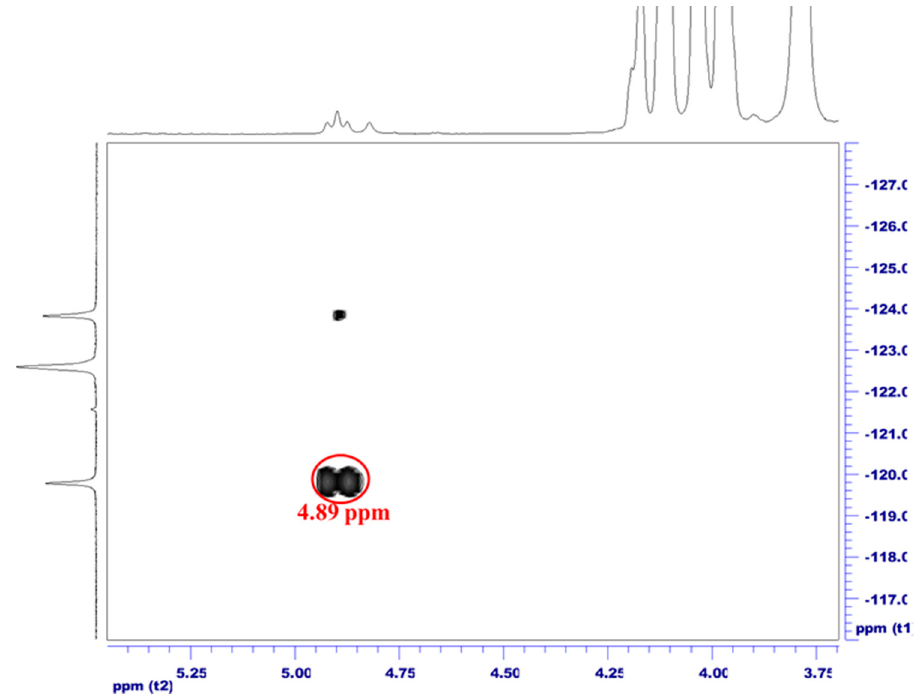
Figure 7. 1 H– 19 F COSY NMR of PFD/PU-03.